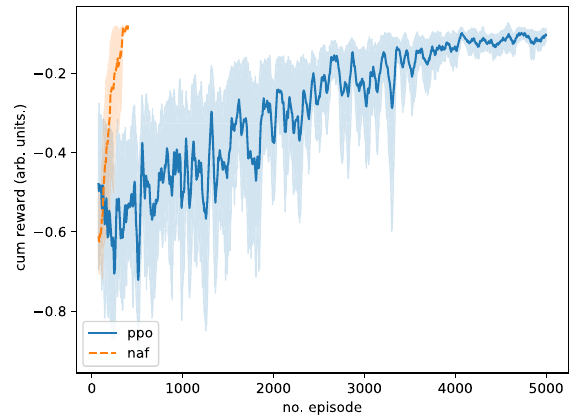
FIG. 15. A comparison between the on-policy state-of-the-art algorithm PPO and the NAF algorithm for the AWAKE trajectory correction problem. The cumulative reward was averaged over five different random seeds.